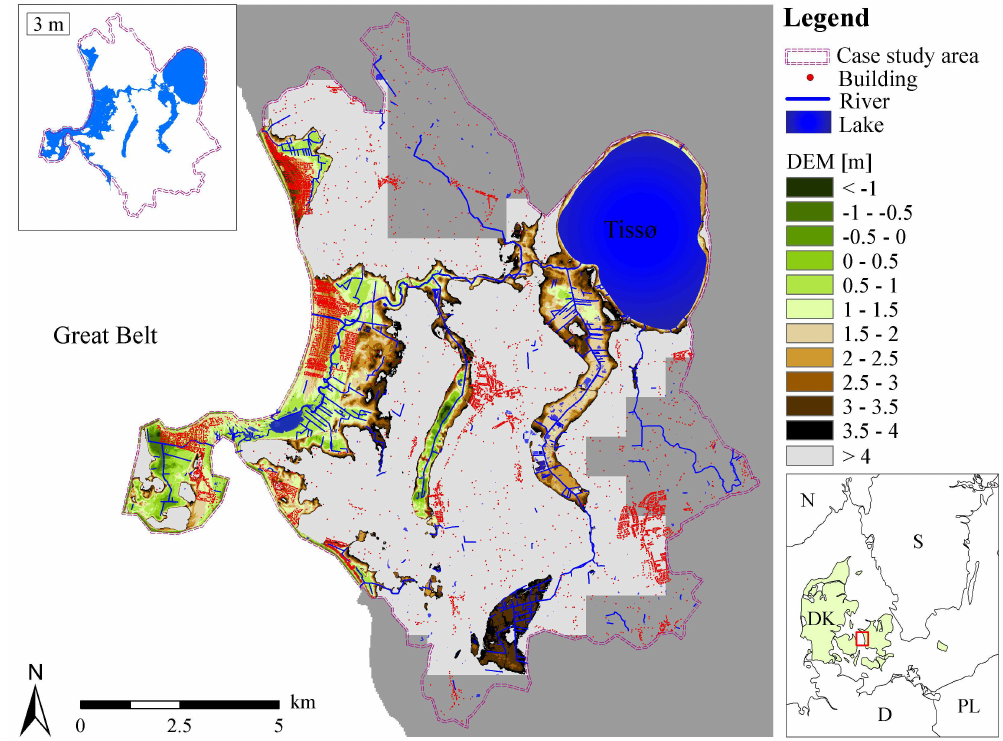
Fig. 1. Map of the case study area and location within Northern Europe. The elevation according to the available DEM is colour coded (light grey represents elevations above 4 m) and buildings are indicated by red dots. The dark grey area delineates land for which no elevation data is available and the white area in the east is the sea. The inset in the upper left corner indicates the inundated area for a 3 m sea level referred to DVR90 (no aggregation, 4 nearest neighbours). The inset in the lower right shows the country contours and the cut-out representing the major map. DEM owned by BlomInfo A/S, Denmark.